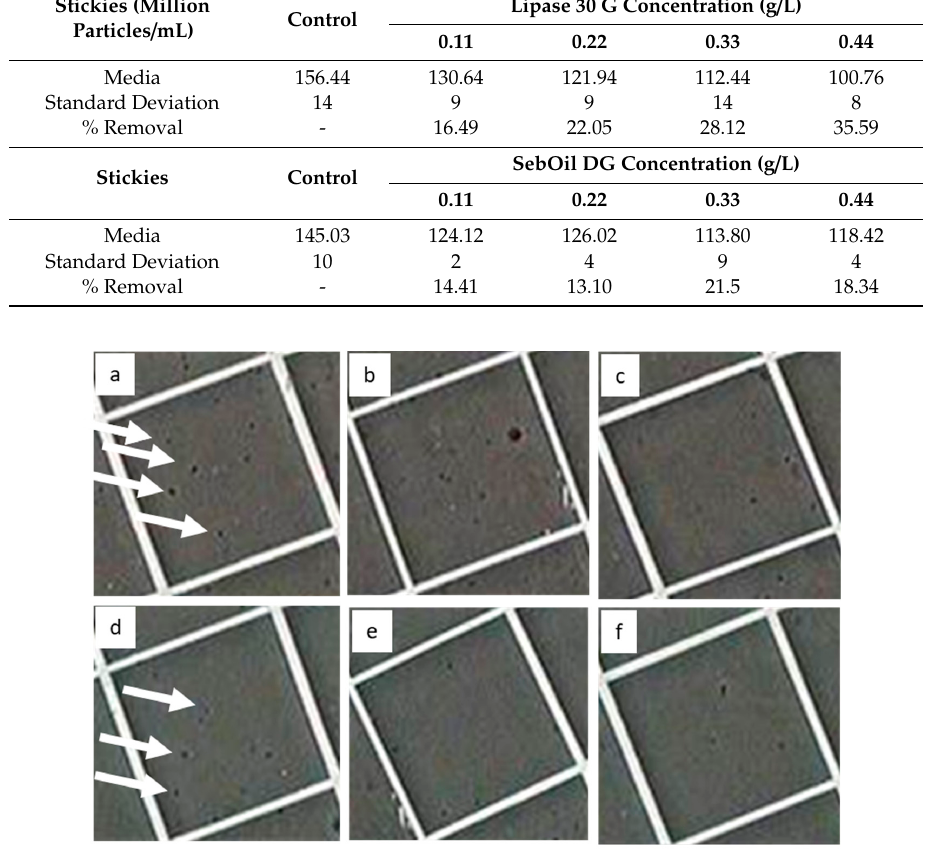
Figure 6. Stickies in paper using the rhodamine method. ( a ) No enzyme added; ( b ) treated with Lipase 30 G at 0.44 g/L. Large stikies are denoted by an arrow. Table 5. Mean stickies removal for treatments with the commercial enzymes at 0.44 g/L, measuring stickies in paper gravimetrically.